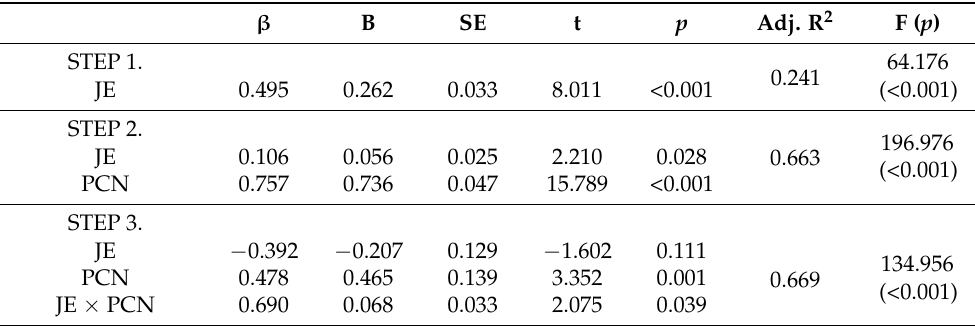
Table 5. Moderating effect of person-centered nursing on the relationship between job engagement and quality of nursing services ( N =